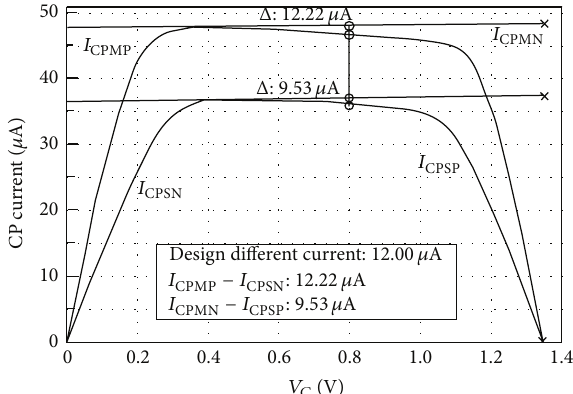
Figure 11: Circuit diagram of CP. The CP consists of the CPM and the CPS.